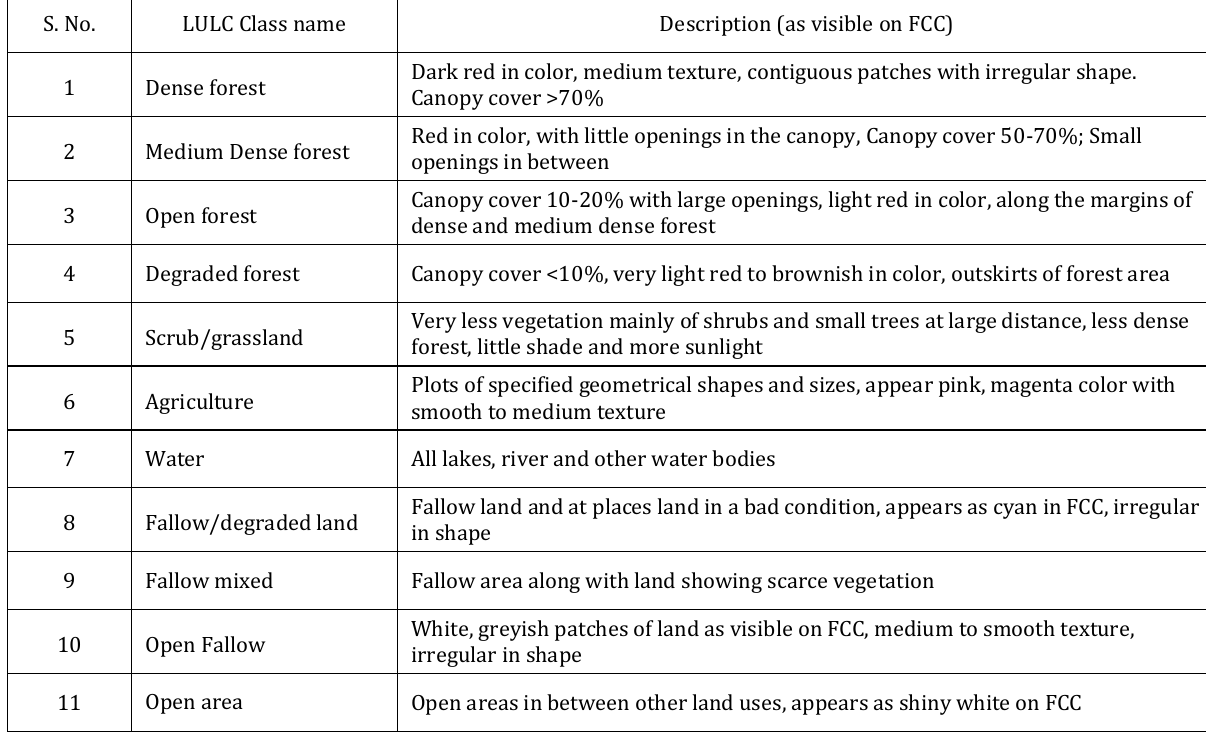
Table 2. A brief description of the land use and land covers (LULCs)